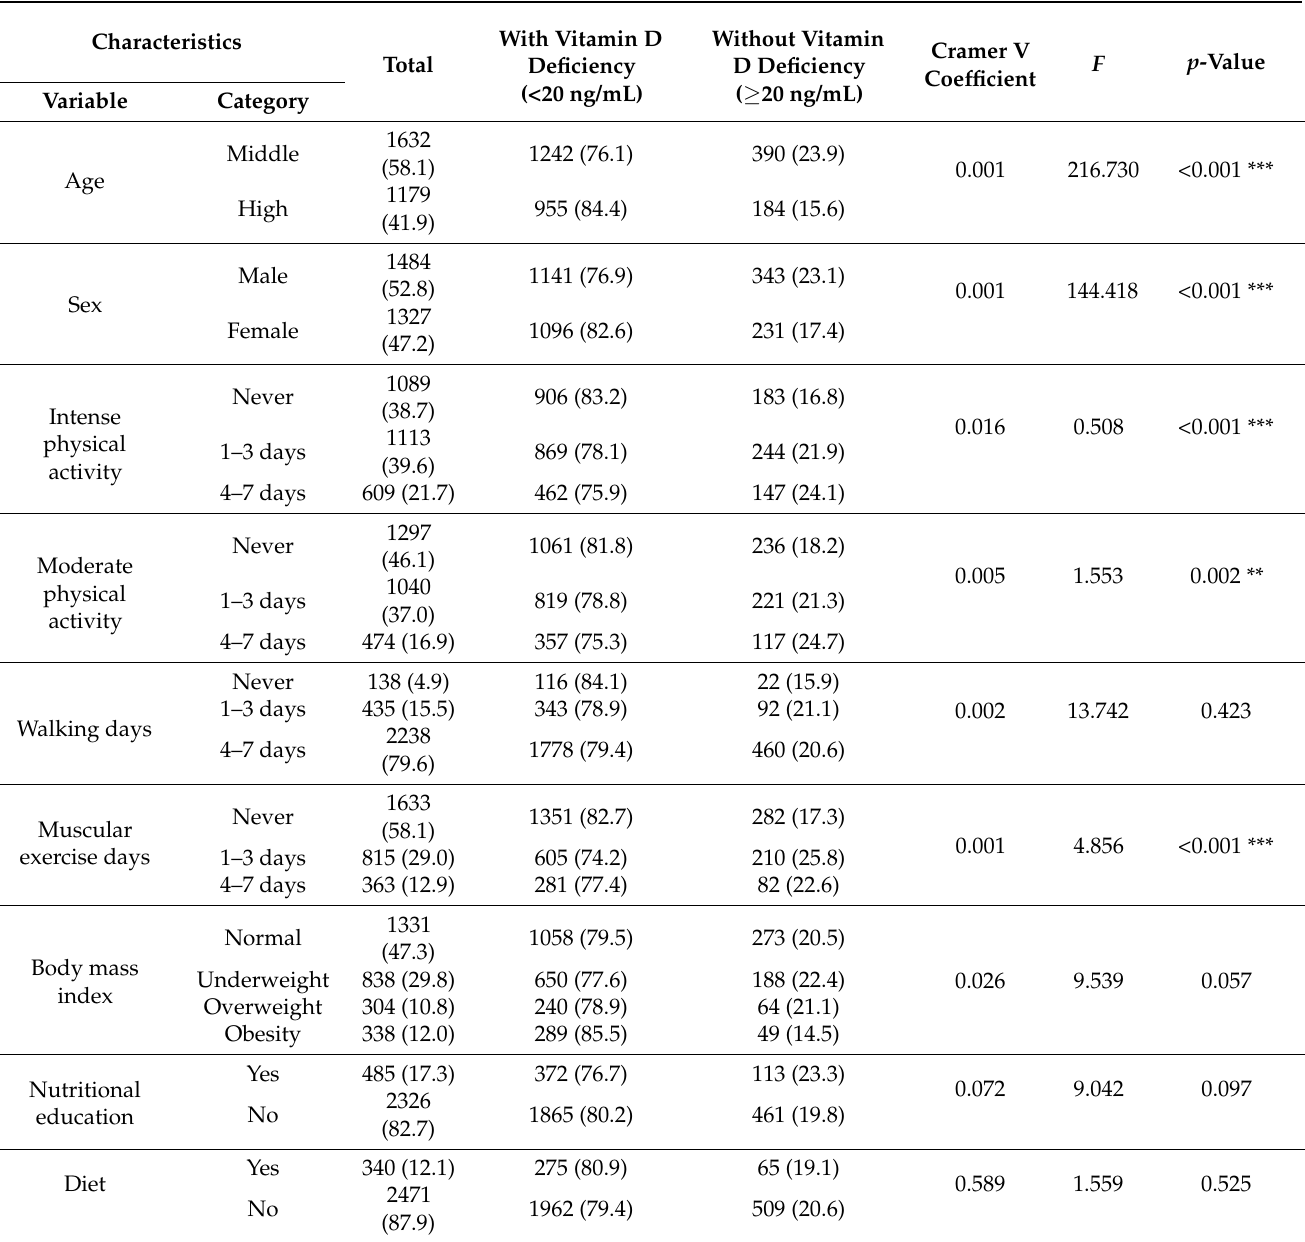
Table 1. Baseline characteristics of the study sample.